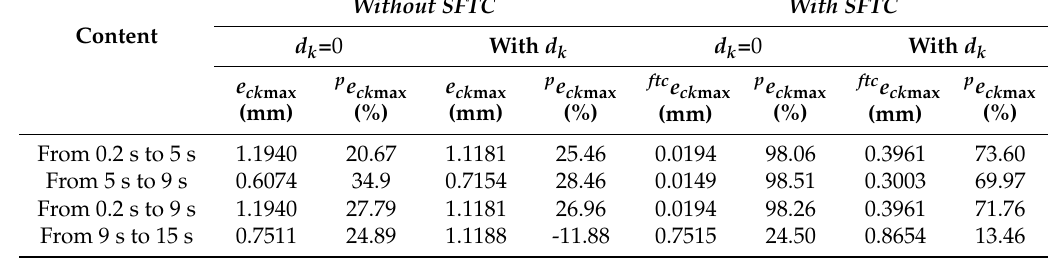
Table 3. The error assessment e ck max using a PID controller with disturbance d k .